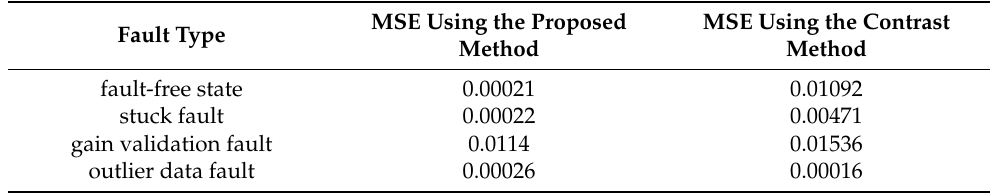
Table 2. Distribution of